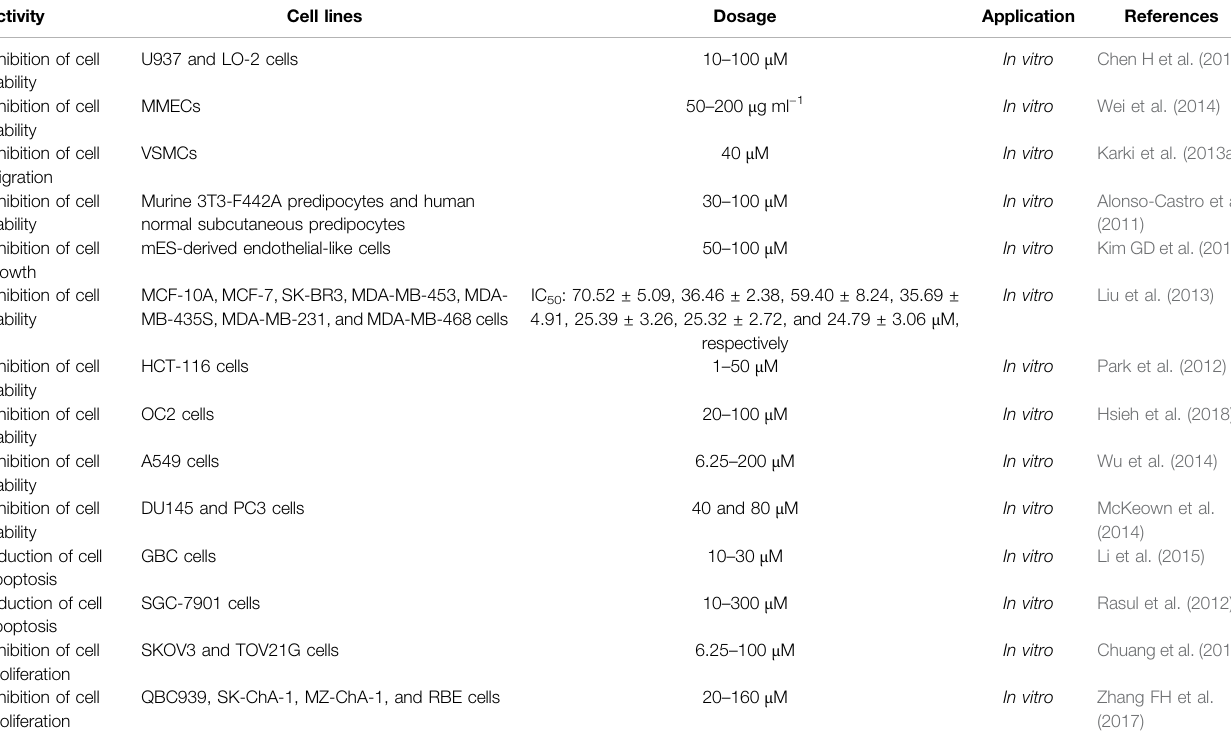
TABLE 2 | Toxicity of